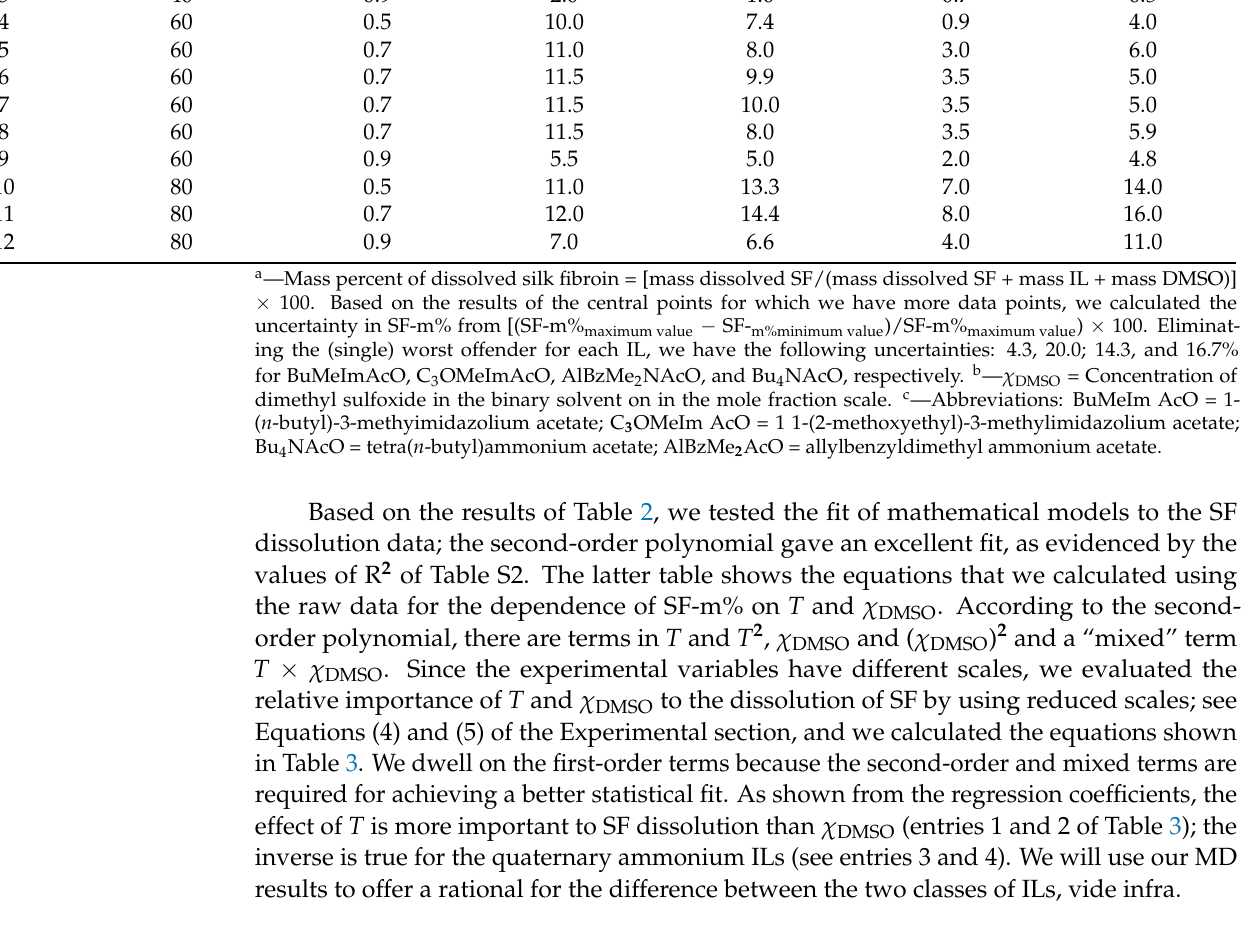
Table 3. Regression equations for the dependence of the mass% of dissolved silk fibroin (SF-m%) on the dissolution temperature ( T ) and the mole fraction of DMSO in the binary solvent, χ DMSO , using reduced variable values, and a second-order polynomial